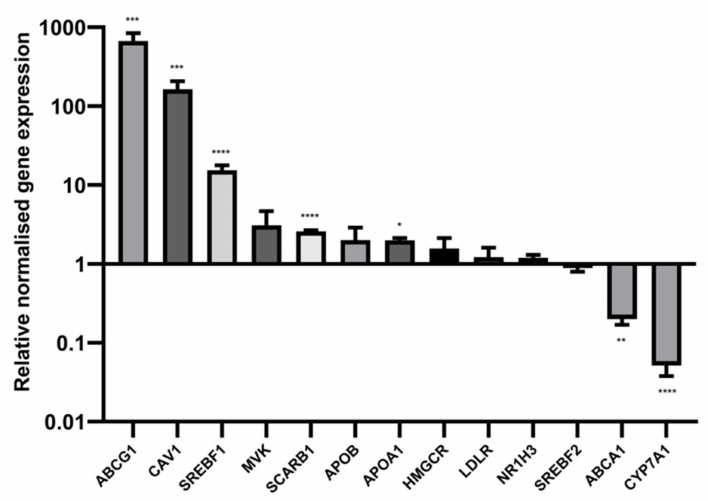
Figure 9. Influence of butyrate on cholesterol-related gene expression in HepG2 cells. Reverse- transcription qPCR results from HepG2 cells treated with 5 mM sodium butyrate for 24 h, normalised to reference genes GAPDH , YWHAZ and RPL13A . Results represent the mean combined from at least three independent experiments, with error bars representing SEMs. * p < 0.05 ** p < 0.01, *** p < 0.001, **** p <